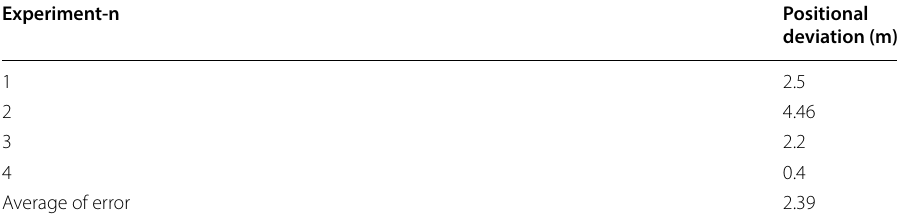
Table 2 Positional deviation from navigation algorithm with course‑over‑ground